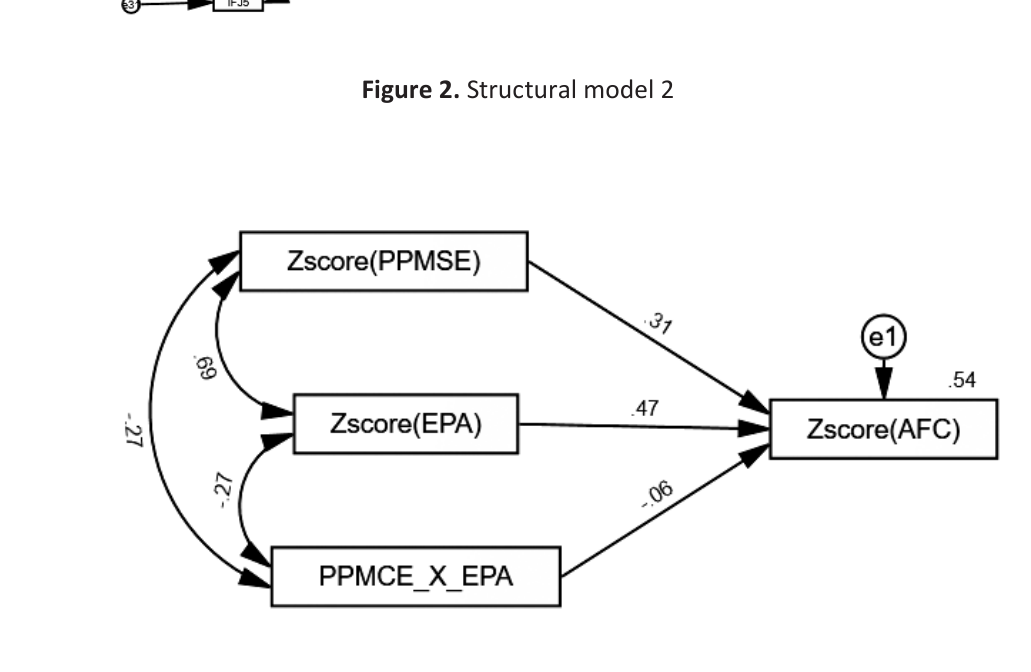
Figure 3. Interaction model